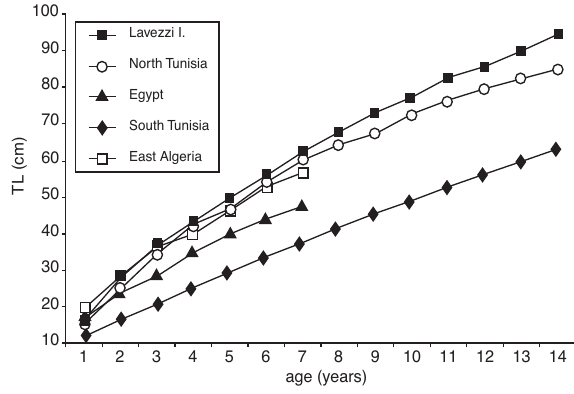
F IG . 3. – Linear growth comparison of E. marginatus ; Egypt: Rafail et al. (1969); South Tunisia: Bouain (1984); North Tunisia: